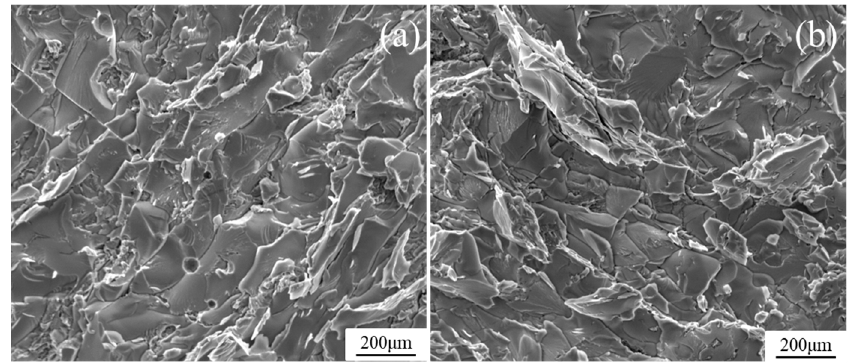
Figure 12. Micromorphology of the delamination for sandwich panels at ( a ) 160 °C and ( b ) 300 °C.